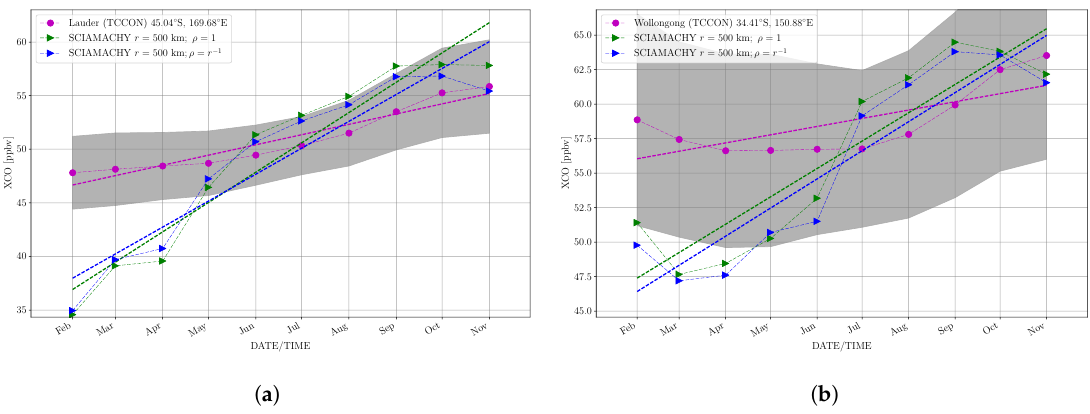
Figure 12. Comparison of intercept and slope of s-b and g-b xCO. The years 2004 through 2011 were included in the analysis for Lauder depicted in ( a ). Results for Wollongong that include data from 2008–2011 are shown in ( b ).